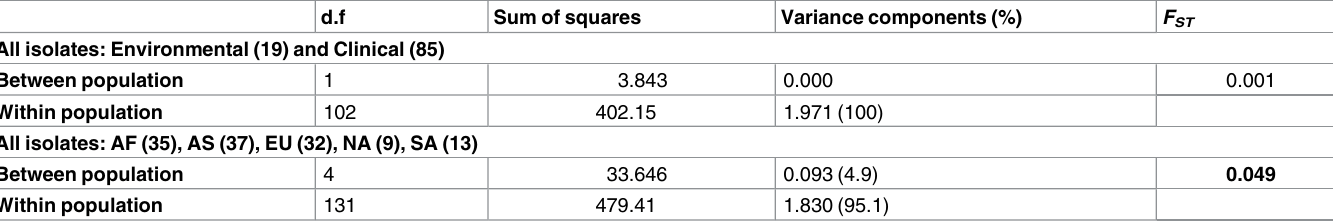
Table 3. Hierarchical Analysis of Molecular Variance (AMOVA) of different continental populations of Cryptococcus neoformans var. grubii VNI. d.f